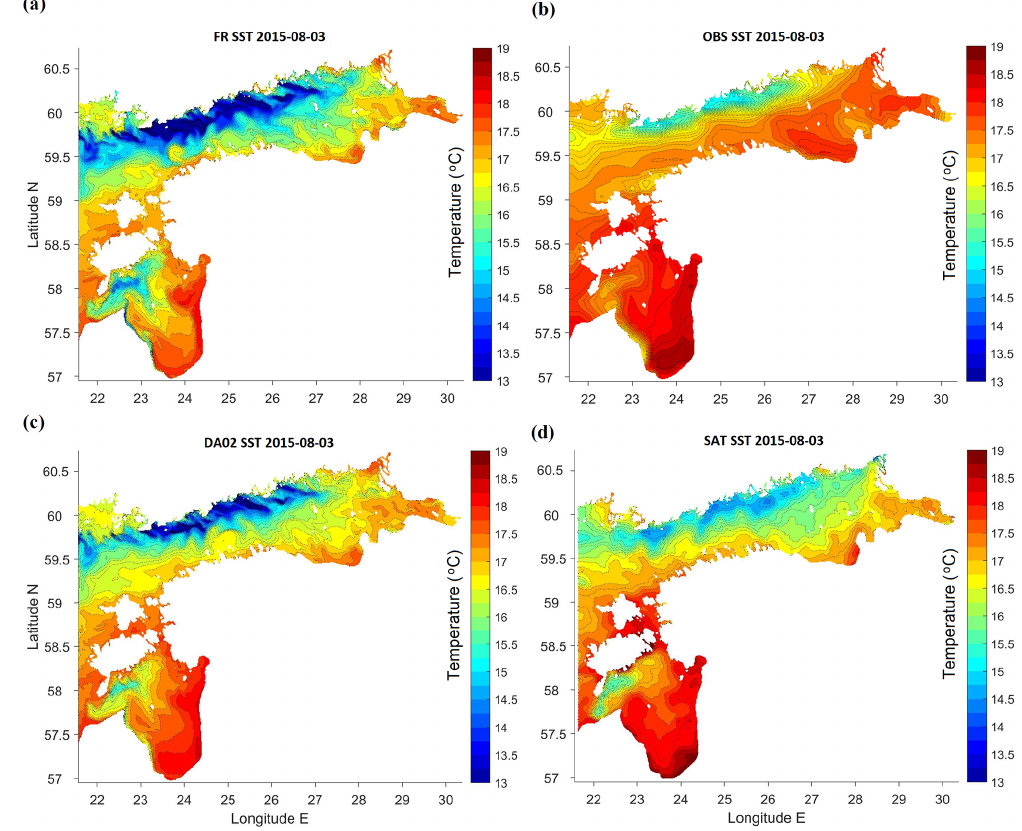
Figure 5. Maps (longitude E, latitude N) of SST in the study area on 3 August 2015: (a) free model run without DA, (b) in situ observations reconstructed using EOF method, (c) DA with relaxation time 5d (weight of observations 0.2), (d) CMEMS product based on satellite